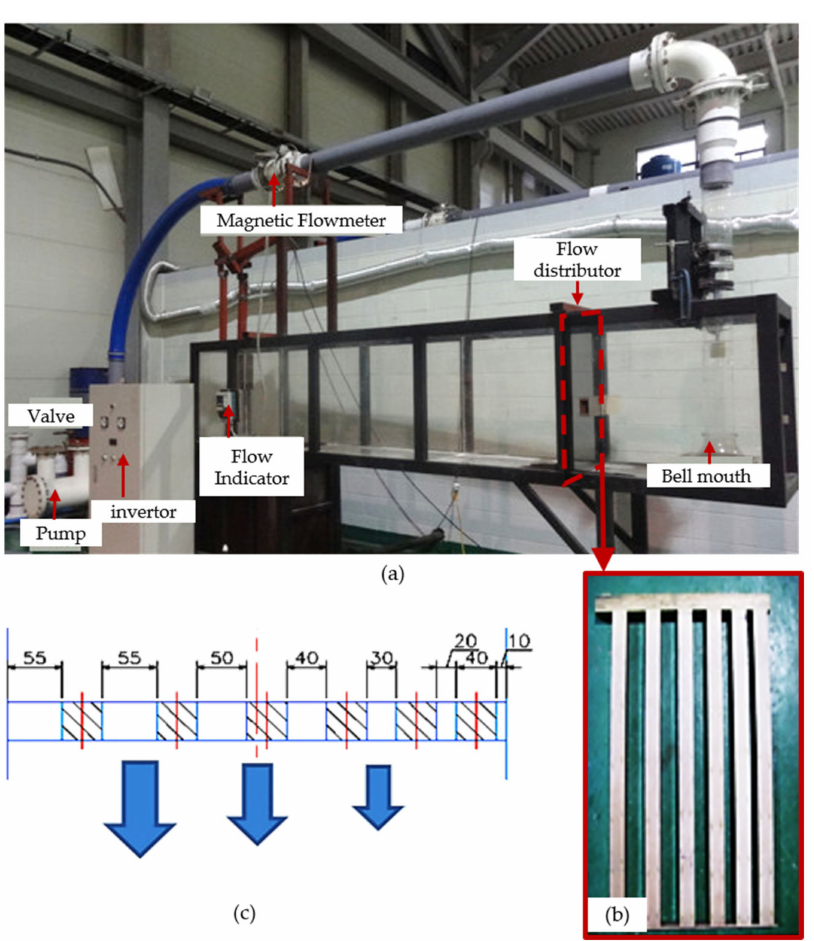
Figure 2. Sump test model: ( a ) experimental set up; ( b ) flow distributor; ( c ) dimension of flow